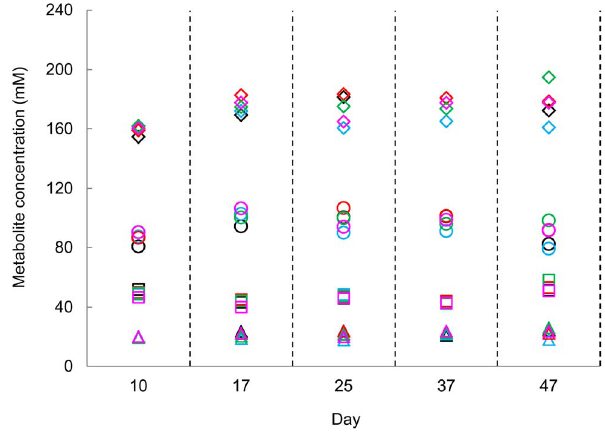
Figure 4. Main metabolites in CR and TR1-4 on the last day of each stabilization period. ( e ) total SCFA; ( # ) acetate; ( % ) propionate; ( D ) butyrate; (black) CR; (blue) TR1; (red) TR2; (green) TR3; (pink)